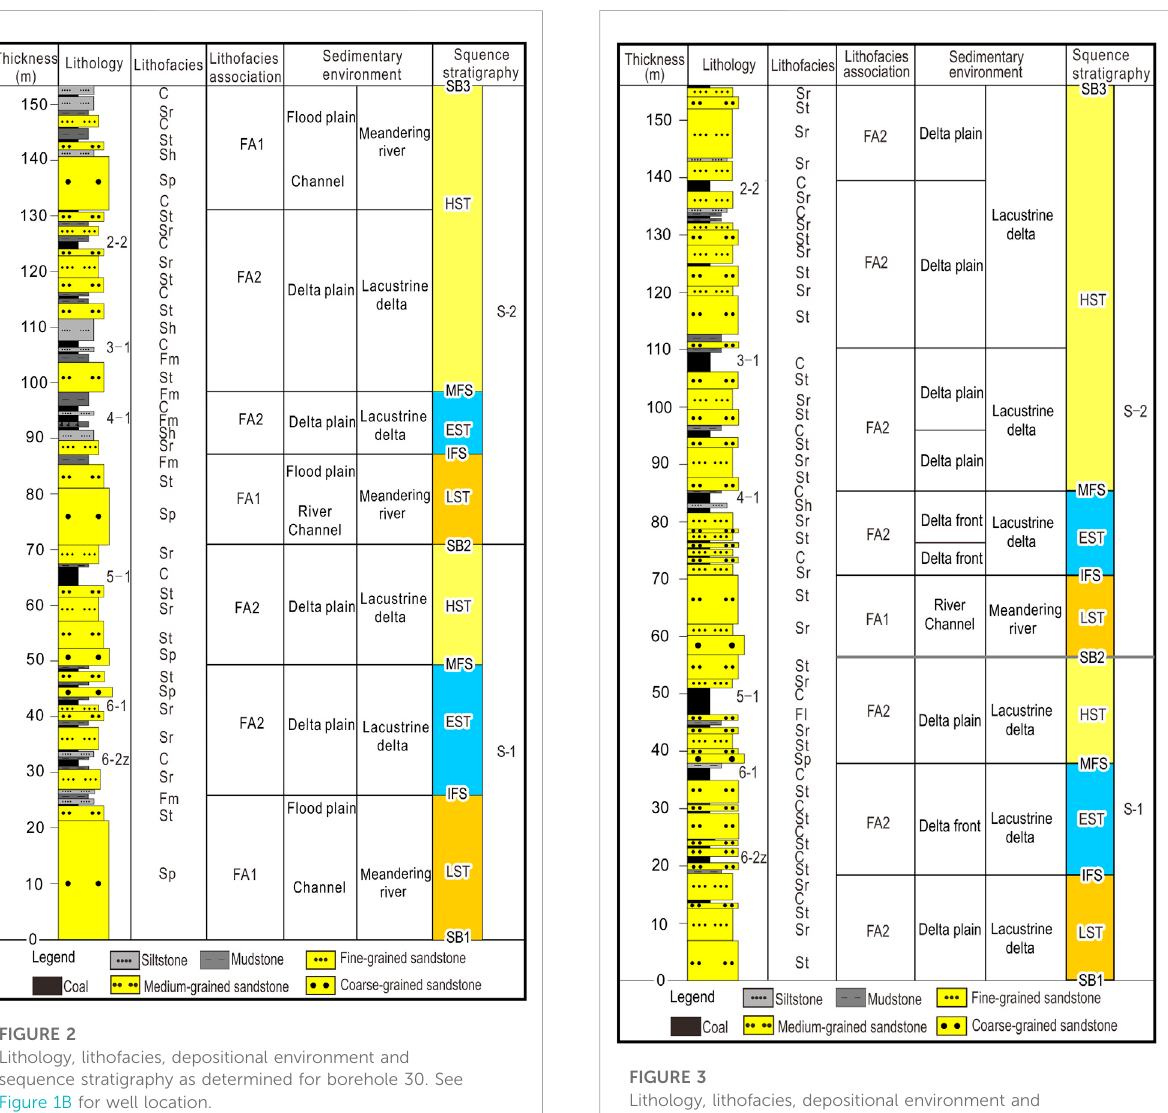
Figure S3C). Sequence S-2 is bounded at the top by sequence boundary SB3, which is the unconformity between the Yan ’ an Formation and the overlying Zhiluo Formation. This unconformity represents an incised valley (Supplementary Figure S3B).